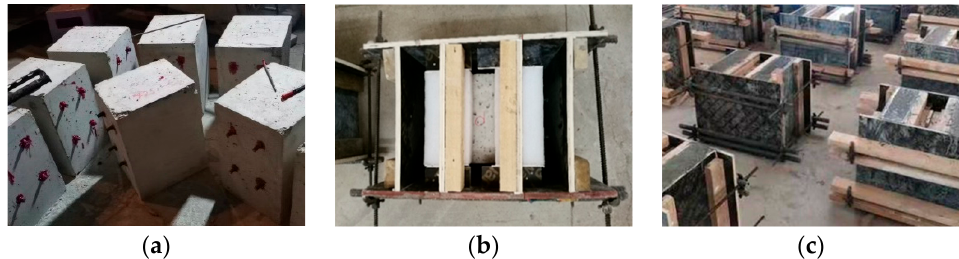
Figure 2. Manufacture of UHPC–NC push-out test specimens ( a ) planting rebar; ( b ) UHPC mold; ( c ) curing of UHPC-NC specimens. ( c ) curing of UHPC-NC specimens.